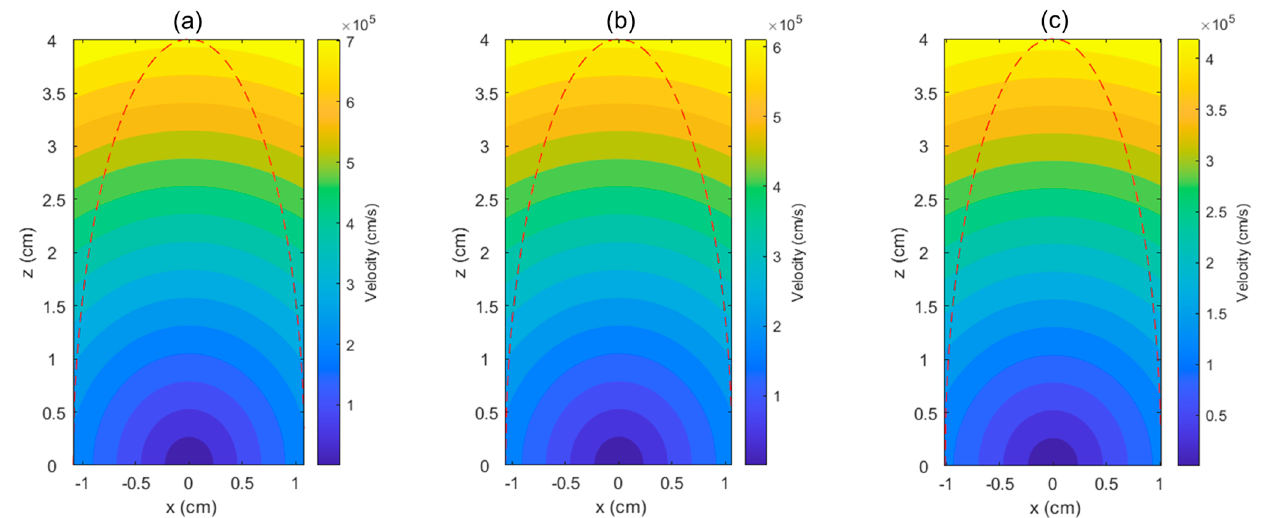
Figure 6. Velocity distribution inside the expanding plasma plume in different initial plasma temperatures, ( a ) T P = 20,000 K, ( b ) 15,000 K, and ( c ) 7000 K. Red-dashed line represent the semi-ellipsoid plasma plume dimension at height of 4 cm.